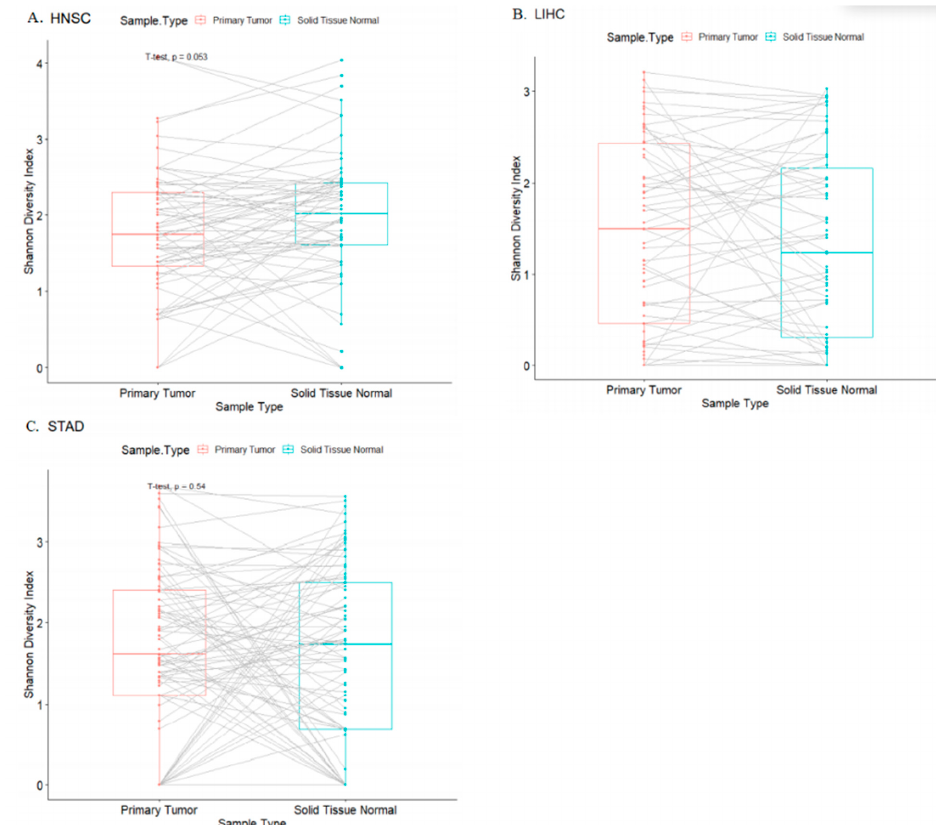
7 of 14 Figure 2. Bacterial within-sample diversity across cohorts comparing tumor to its paired adjacent normal tissue in HNSC ( A ), LIHC ( B ), and STAD ( C ) cancer cohorts. We performed Student’s t -test for continuous variables and Chi-square test for cate- gorical variables to examine differences in population characteristics and clinicopatholog- ical presentation in order to ascertain differences in microbial abundance and diversity profiles. Across cohorts, stratifying by sample type, there were no significant differences metrics such as absolute abundance (S), Shannon-Wiener diversity index (H), and even- ness (H/ls(S)) measurements showed similar patterns in tumor and adjacent tissue sam- ples among different racial groups across cohorts (Figure 3).